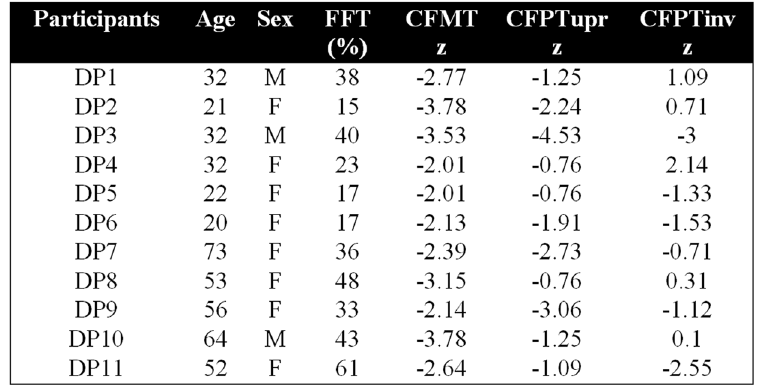
Figure 1. Neuropsychological testing results of the 11 DP cases that participated in the experiments. Columns indicate: Famous Faces Test (FFT), Cambridge Face Memory Test (CFMT), Cambridge Face Perception Test upright and inverted (CFPTupr and